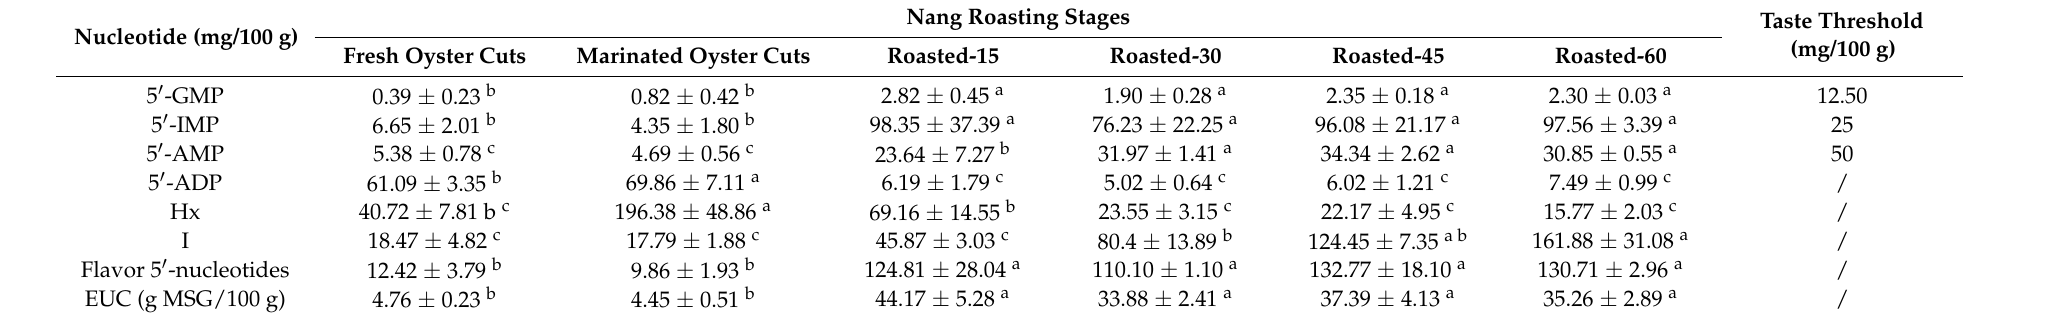
Table 4. Changes of 5 (cid:48) -nucleotides in lamb oyster cuts during Nang roasting (dry matter